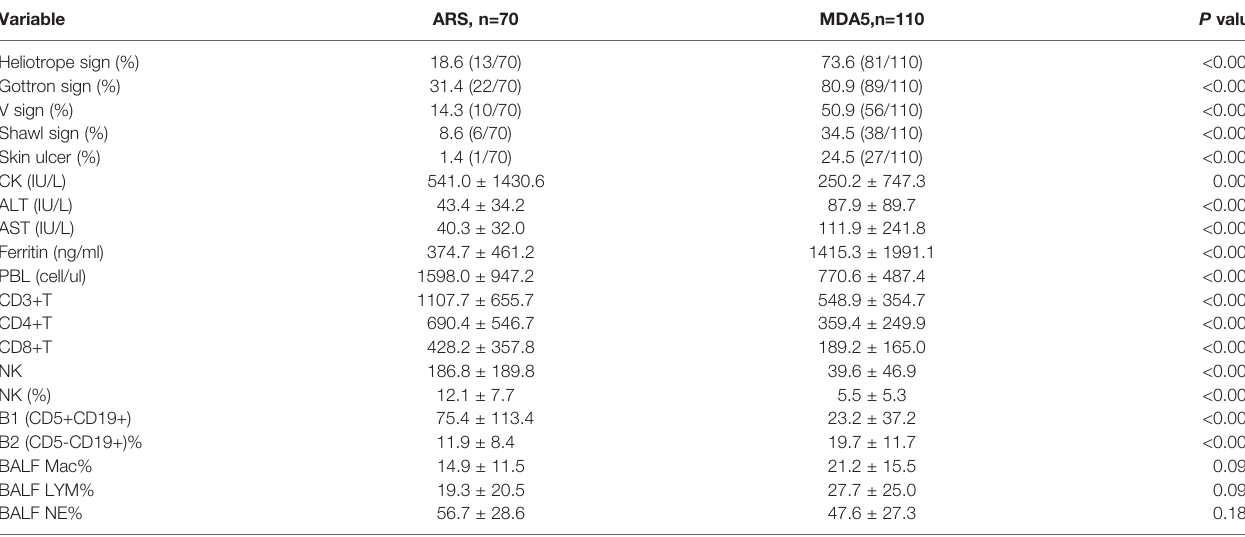
TABLE 3 | Clinical difference between anti-MDA5 positive and anti-ARS positive patients with RP-ILD. Variable ARS, n=70 MDA5,n=110 Heliotrope sign